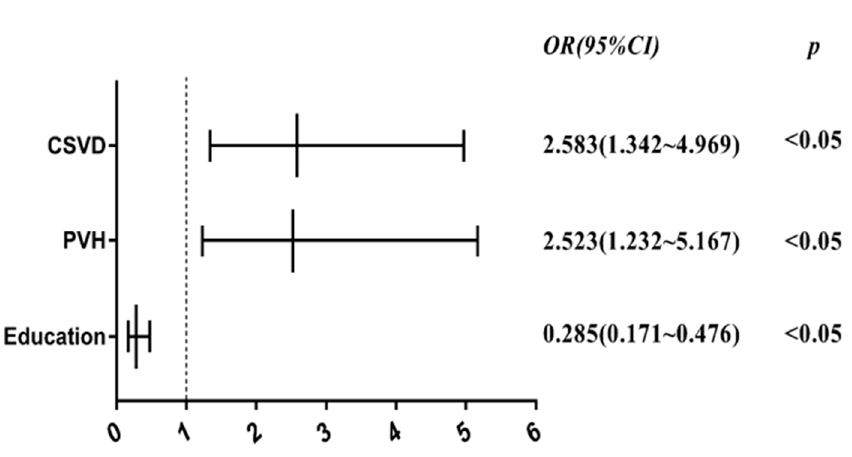
Figure 4. Forest plot of multivariate binary logistic regression analysis.